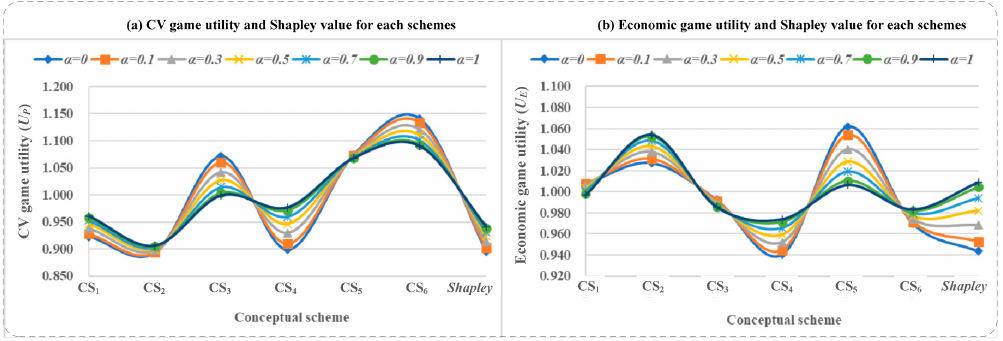
Figure 5. Sensitivity analysis of scheme decision process based on α value.